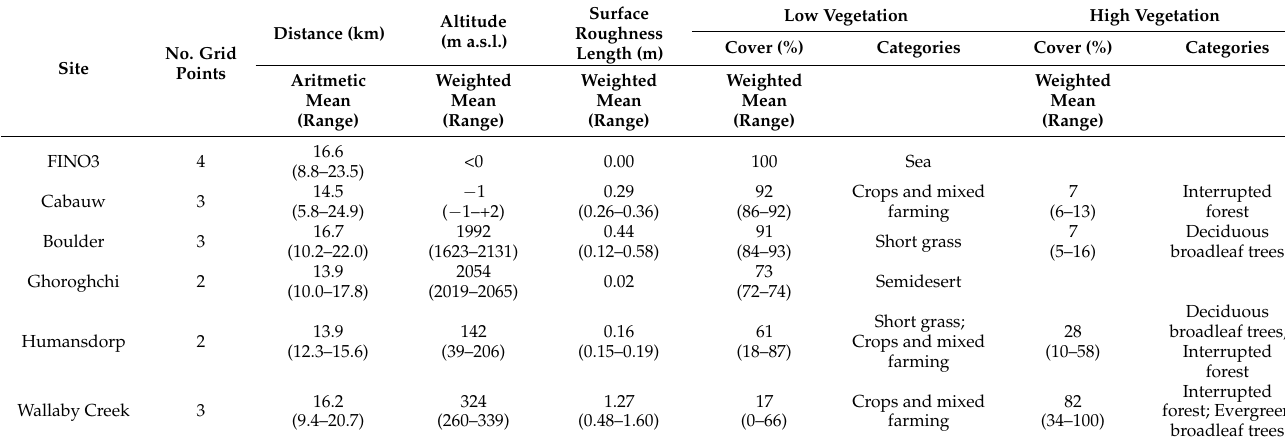
Table 3. Ensemble statistics of terrain and land cover characteristics of ERA5 grid points falling within a 0.25-deg buffer from each site’s location 1,2,3,4,5